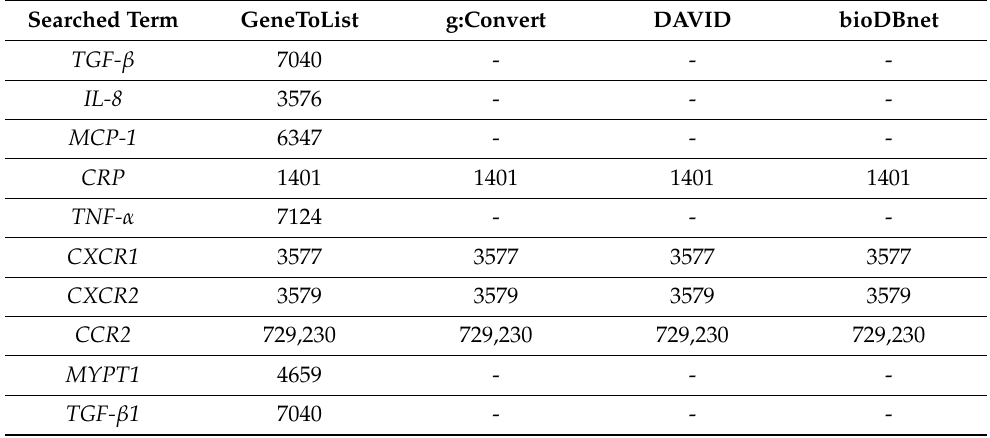
Table 2. Results of the gene ID conversion from GeneToList and other common conversion